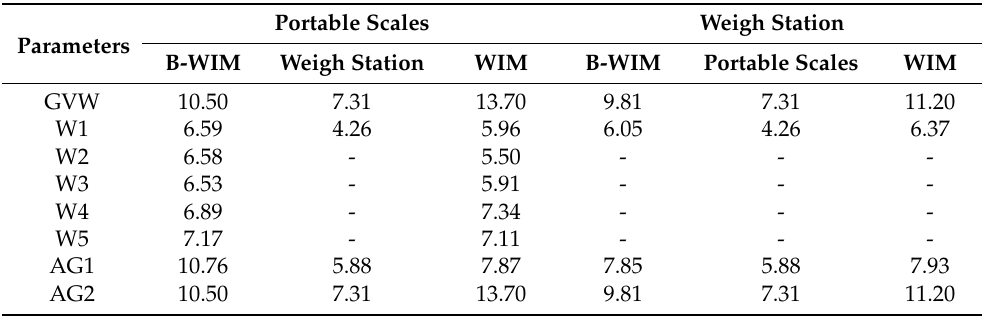
Table 6. Multiple t -tests for paired means compared to the portable scales and weigh station mea-